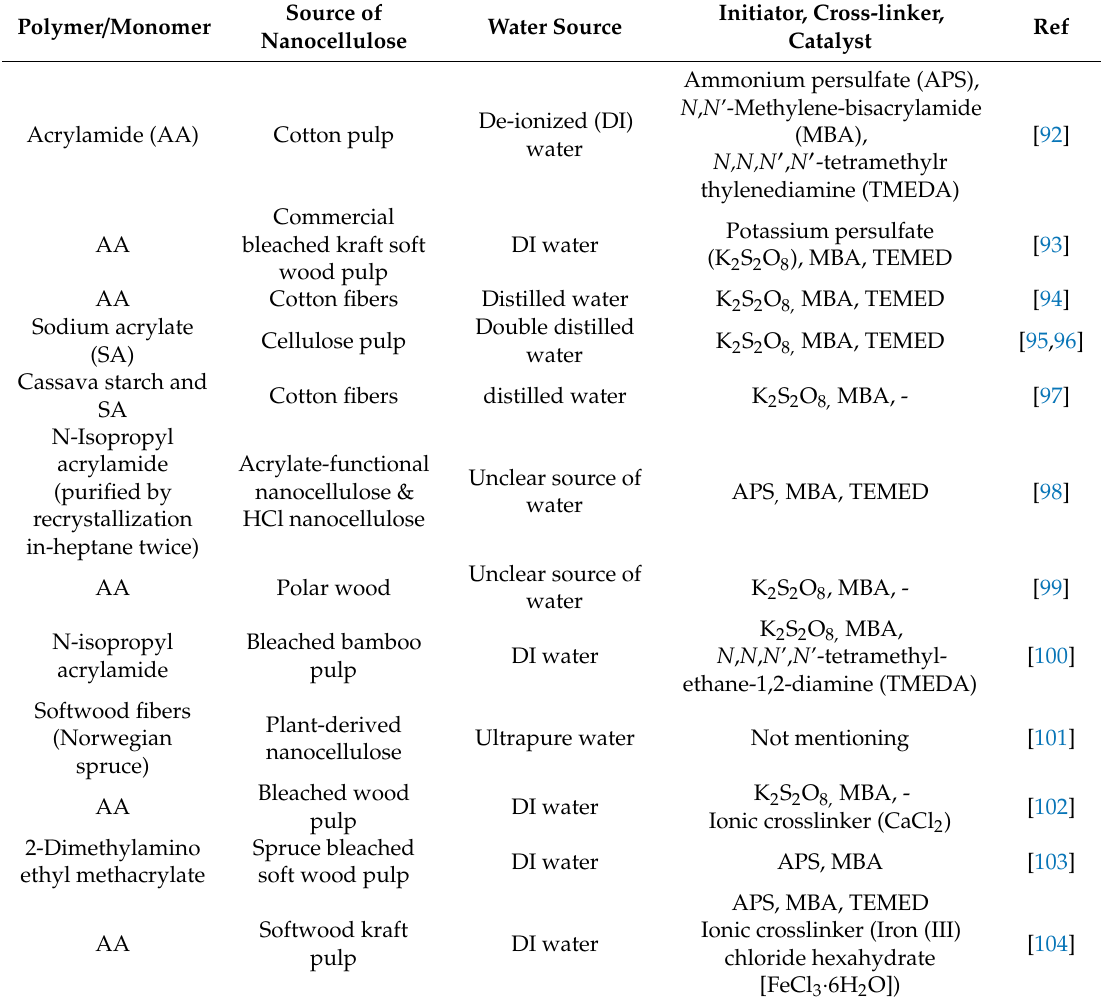
Table 1. Details of previous studies using the free radical polymerization processing method to produce nanocellulose